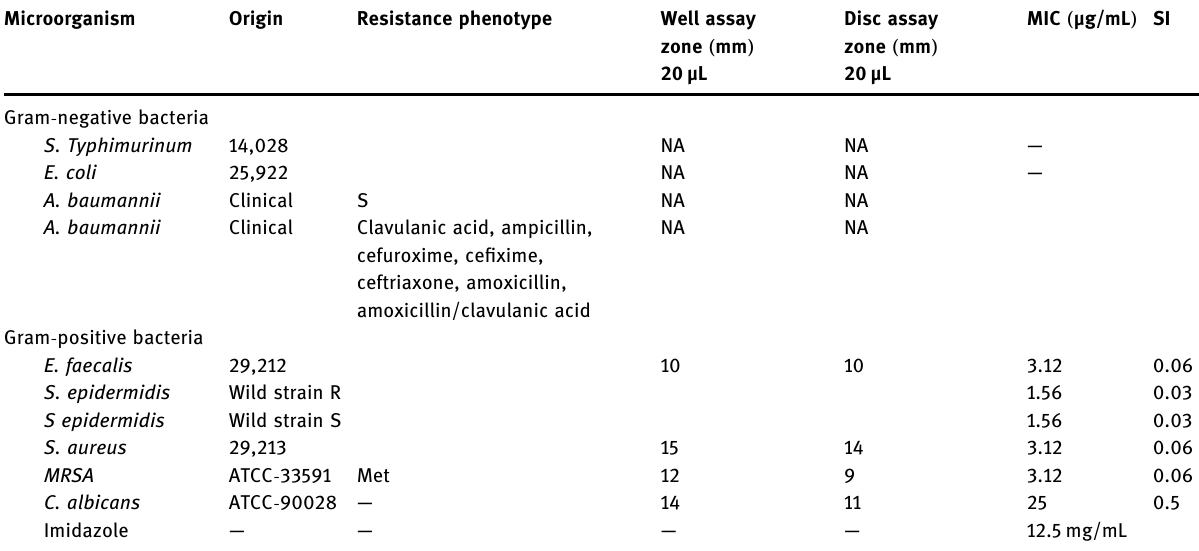
Table 1: Antimicrobial activity of the MFC extract